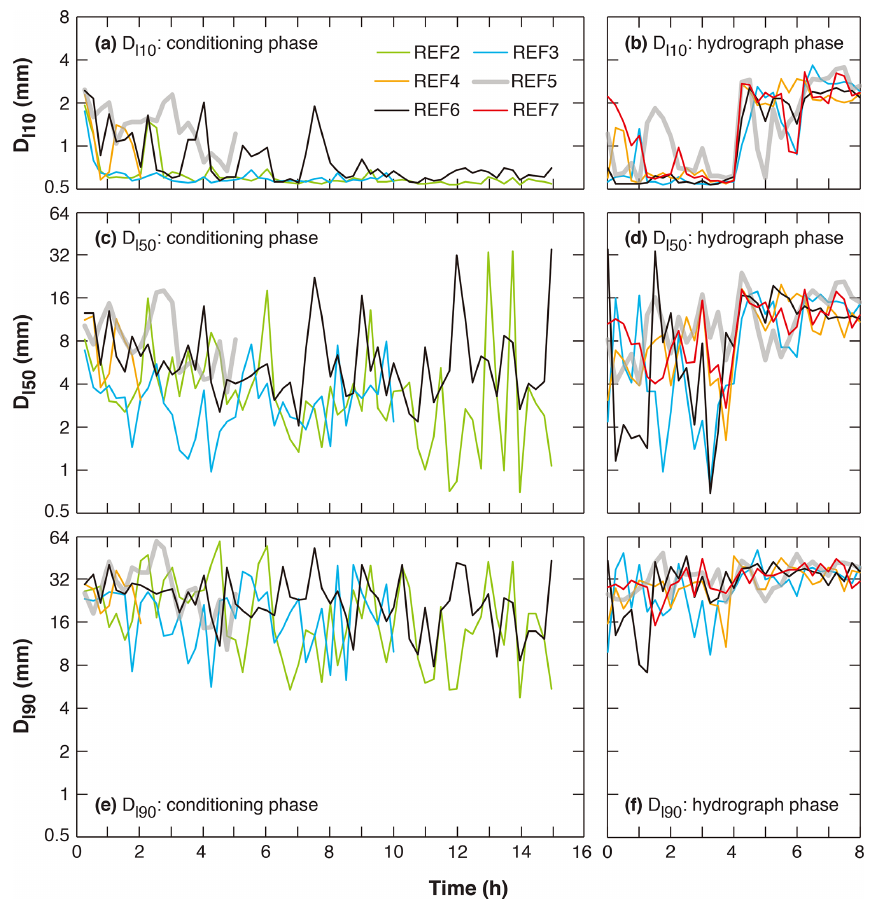
Figure 8. Temporal adjustments of characteristic grain sizes of bed load: (a) D l10 during conditioning phase, (b) D l10 during hydrograph phase, (c) D l50 during conditioning phase, (d) D l50 during hydrograph phase, (e) D l90 during conditioning phase, and (f) D l90 during hydrograph